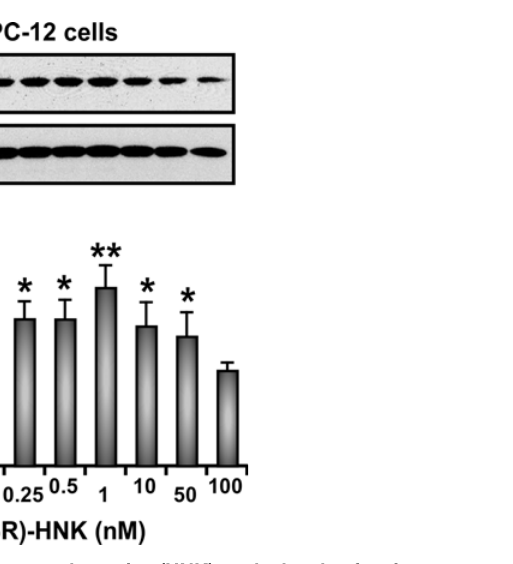
Fig 2. Effect of (2R,6R)-hydroxynorketamine (HNK) on the levels of serine racemase protein in PC-12 cells. Cells were treated with various concentrations of HNK for 36 h and then total cell lysates were prepared for Western blot analysis. Top panel: representative immunoblot of monomeric serine racemase (m-SR; 36-kilodalton band). The blot was reprobed for β -actin, which was used as loading control. Bottom panel: relative levels of m-SR after quantification and normalization with β -actin. Bars represent the means ± SD of three independent experiments. * P < 0 . 05 and ** P < 0 . 01 as compared with control cells.